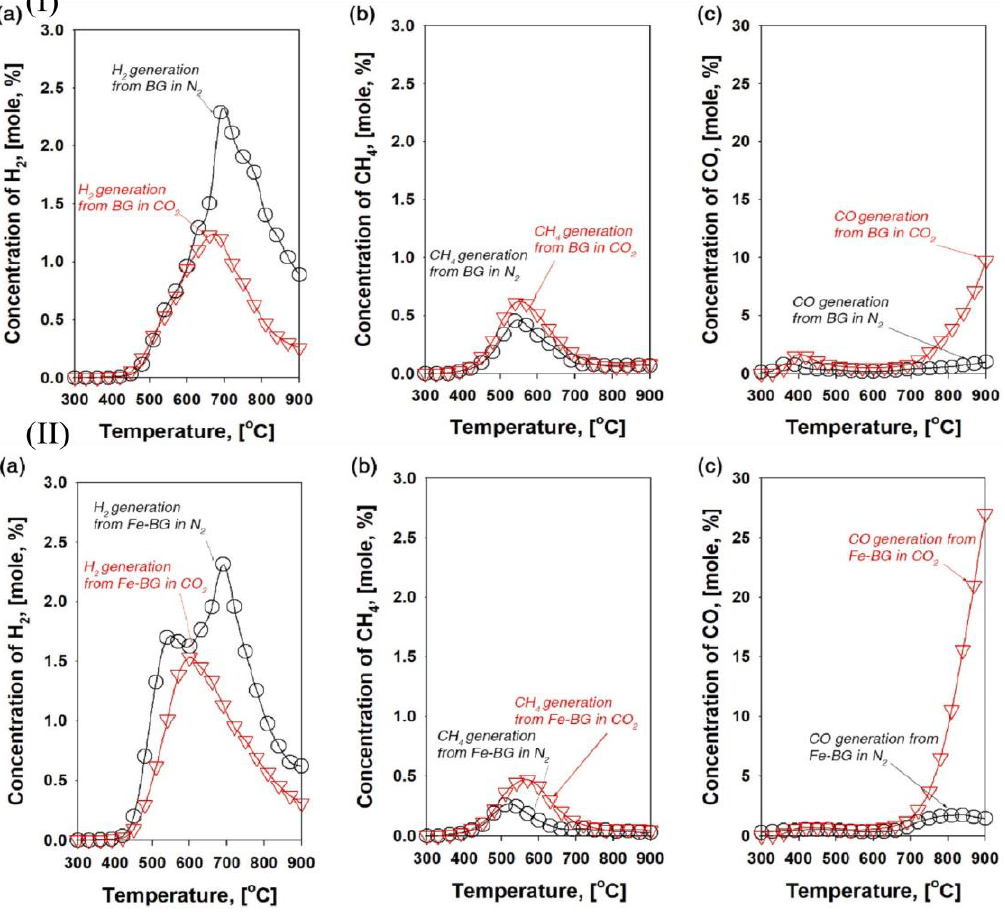
Figure 7. ( I ) Concentrations of H 2 ( a ), CH 4 ( b ), and CO ( c ) formed during the pyrolysis of grass cut under the CO 2 and N 2 conditions. ( II ) Concentrations of H 2 ( a ), CH 4 ( b ), and CO ( c ) formed during the pyrolysis of Fe-bentonite under the N 2 and CO 2 conditions. Reprinted from [66]. Copyright (2022), with permission from Elsevier.